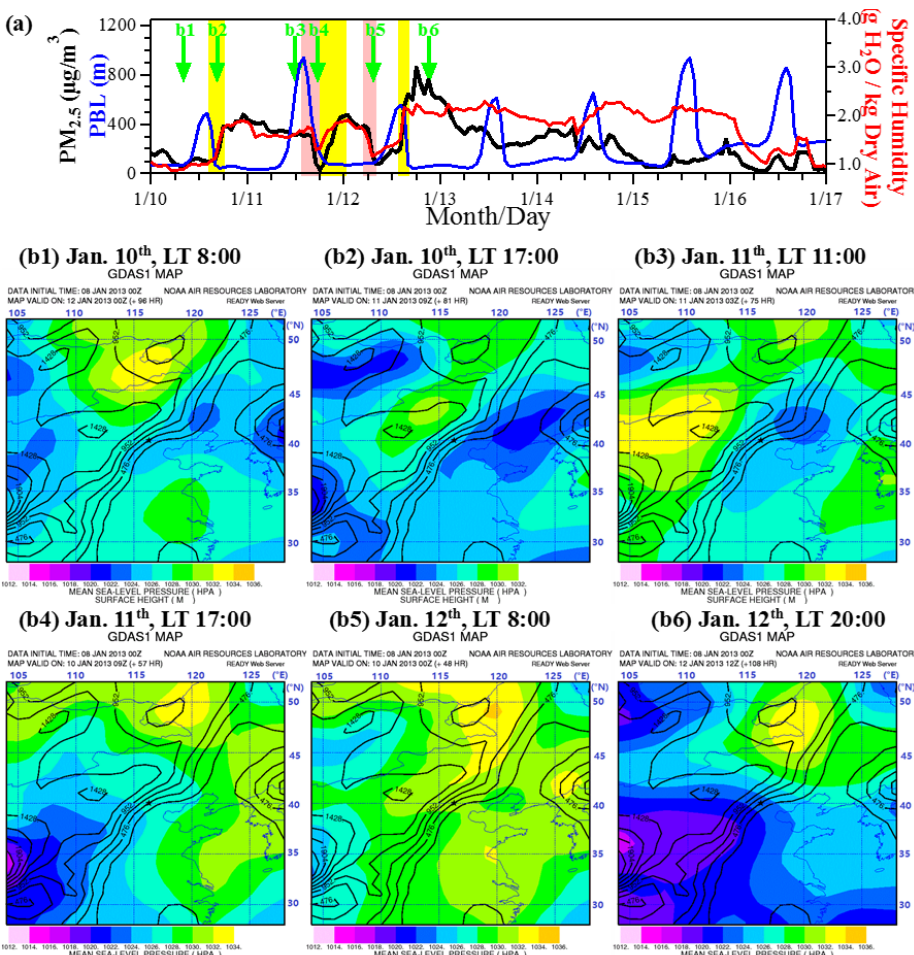
Figure 7. Evidence for regional transport of pollutants as a major factor contributing to sharp concentration increases in Beijing. (a) PM 2 . 5 concentration, PBL height, and specific humidity in Beijing for 10–17 January 2013. Pink and yellow rectangles indicated the sharp drop and sharp increase periods of PM 2 . 5 , respectively. Note how nicely specific humidity and PM 2 . 5 followed each other during these periods. (b) Weather patterns before and after the sharp increases events. Corresponding time point of (b1) to (b6) was indicated by arrows in (a) . The topography map (elevation) is also shown for reference. Location of Beijing was indicated by the black star in center of each